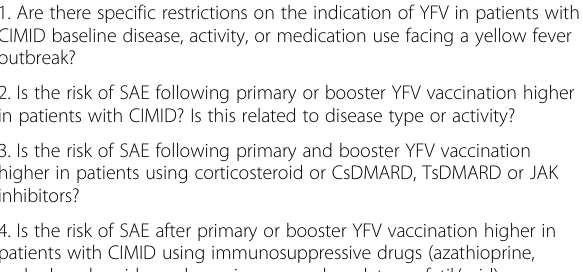
Table 2 Questions used to formulate the